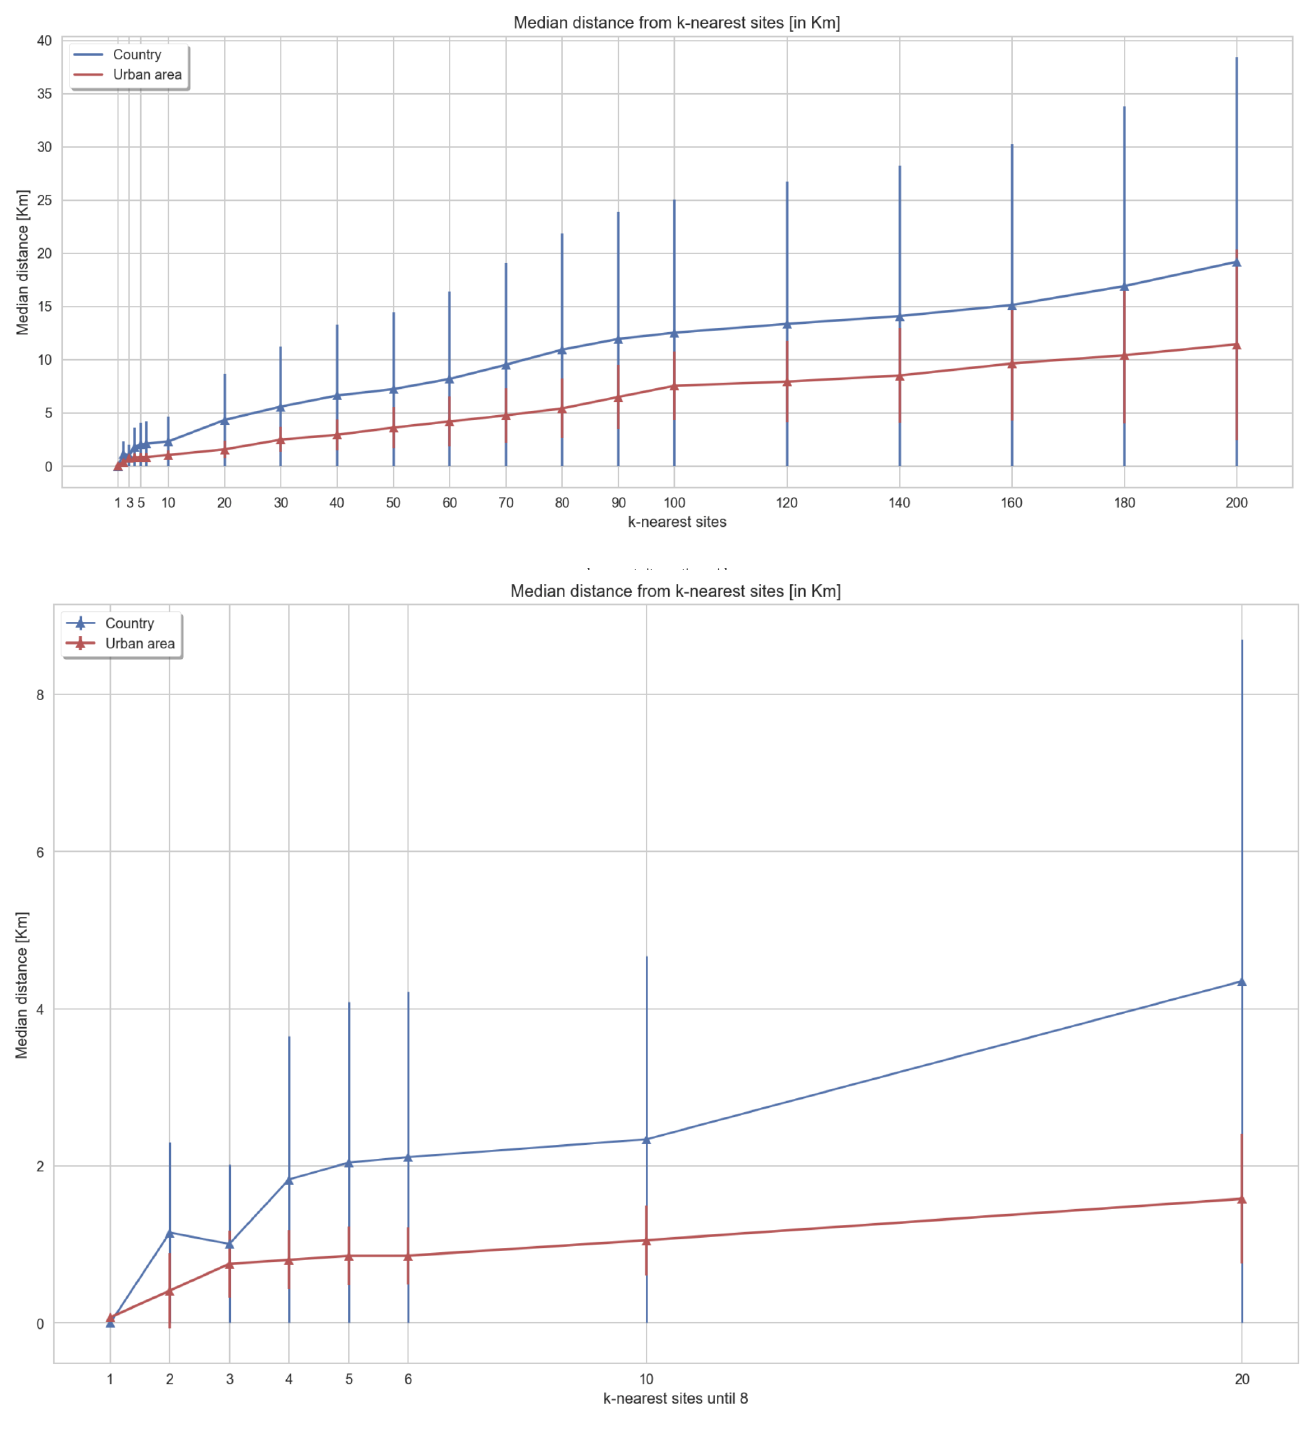
Figure 6. Urban and rural site